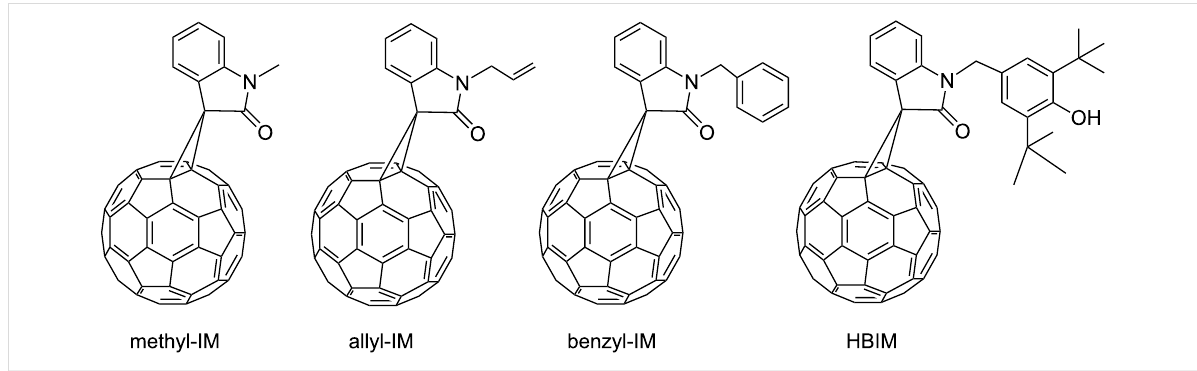
Figure 1: Structures of the indolinone-substituted methanofullerenes prepared earlier.